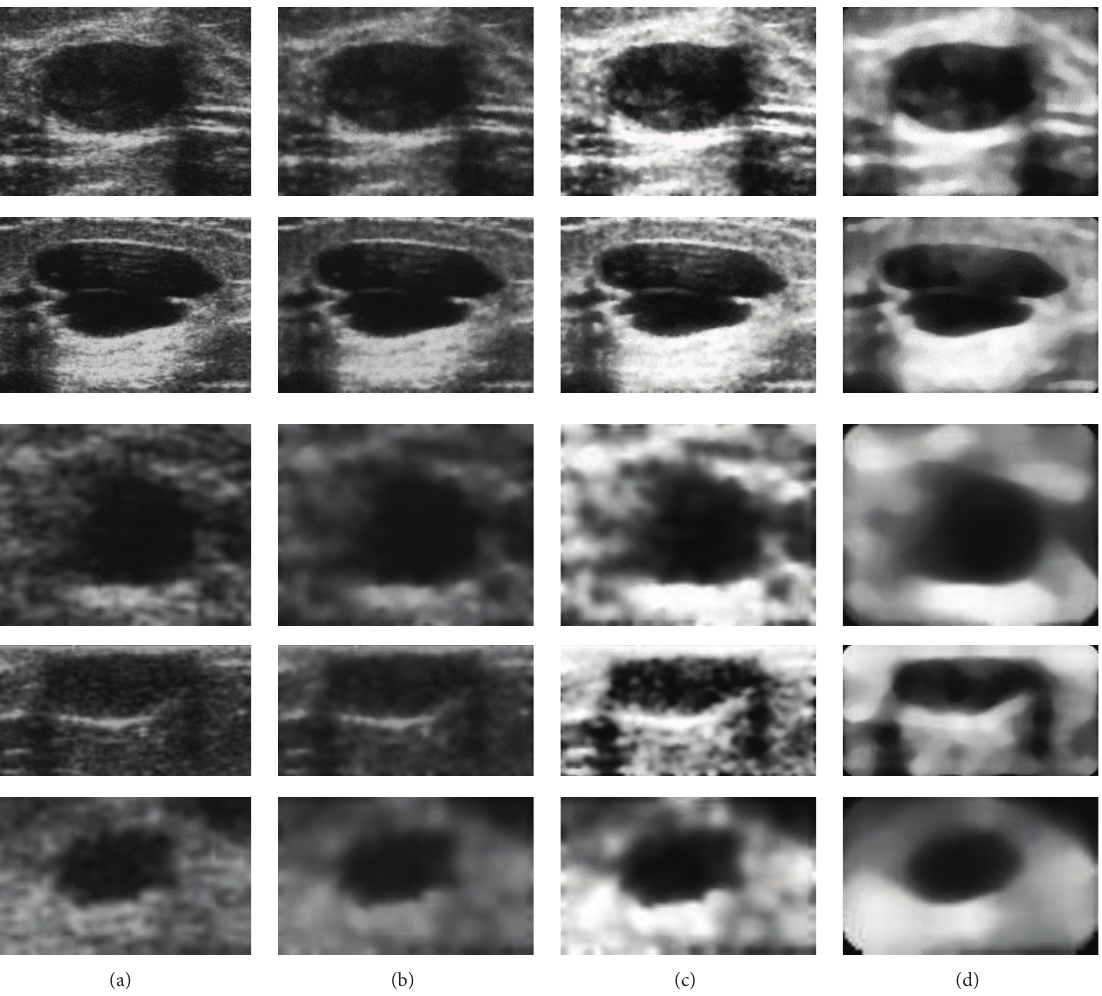
Figure 6: Preprocessing application to ROIs from actual breast ultrasound images: (a) original image; (b) after Wiener filtering; (c) with equalization; and (d) after being submitted to a median